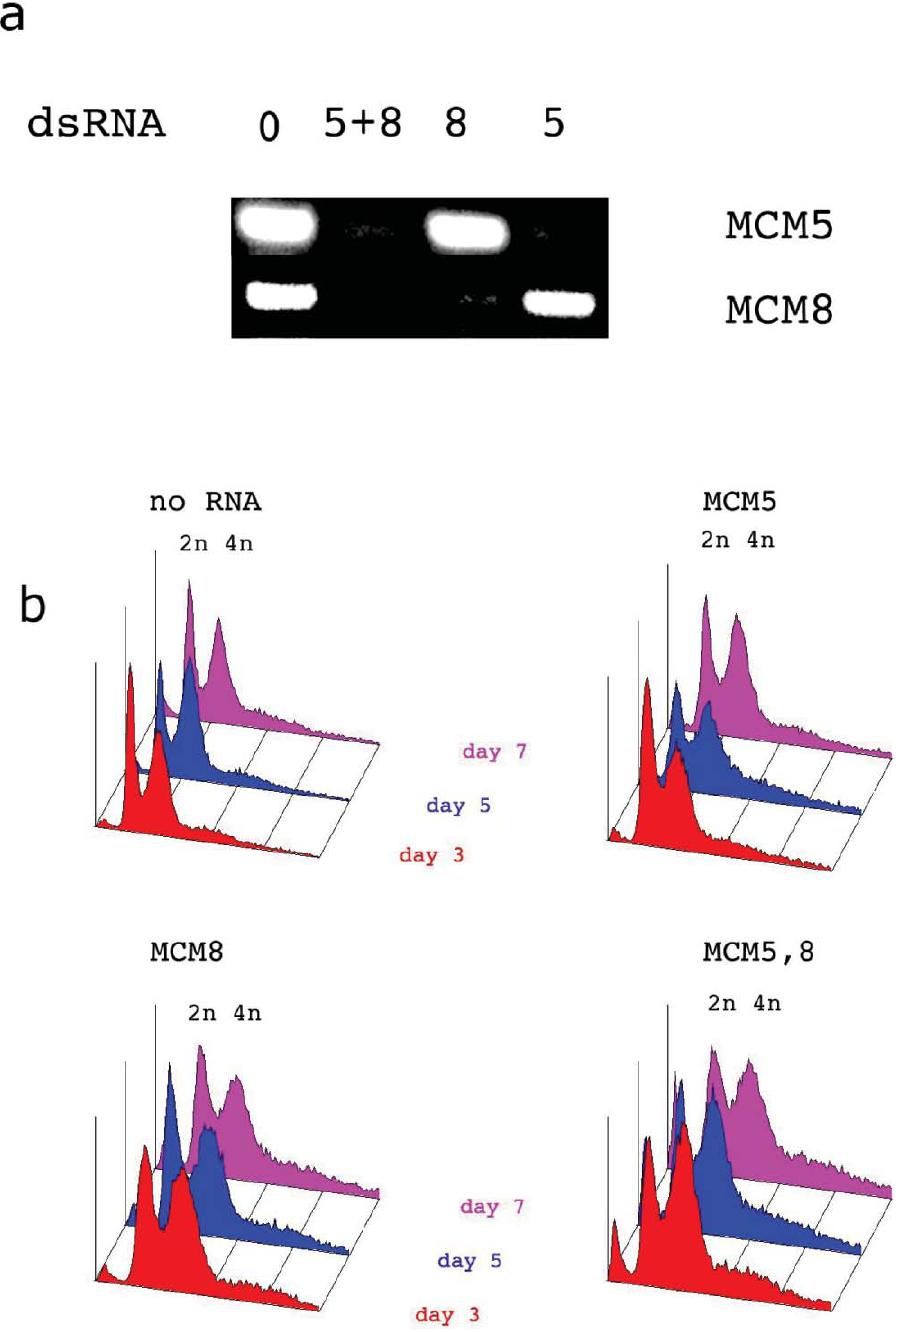
Figure 6. a. Agarose gel of RTPCR products to show the effects of RNAi depletion of MCM5 and MCM8 and MCM 5 plus 8 on the MCM5 and 8 levels. b. FACS profiles of cells targeted with dsRNA against MCM8, and MCM5 plus MCM8. The data presented is one complete representative data set from multiple repetitions.